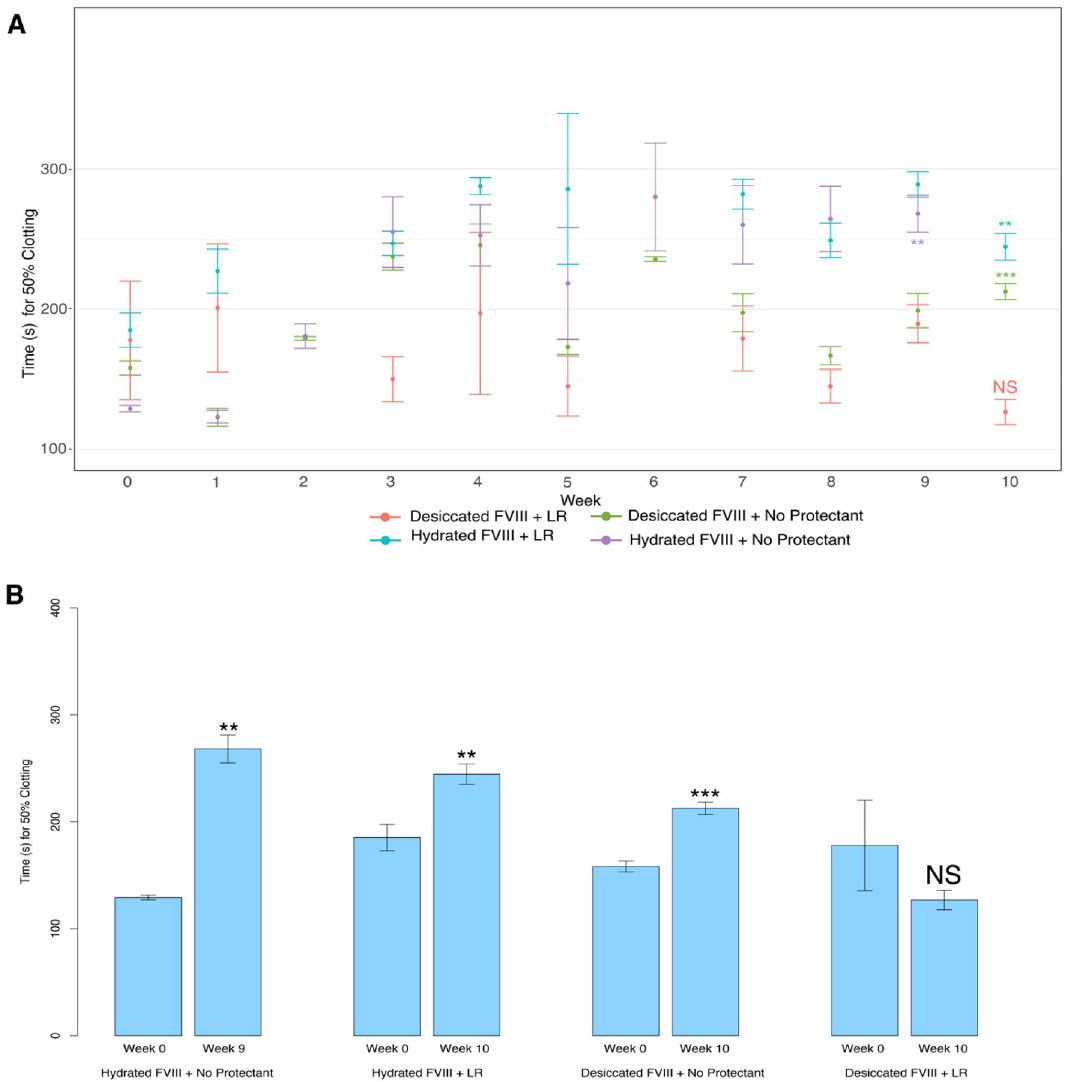
Figure 8. CAHS D Linker Region time course stabilization. 50% clotting time of FVIII in a hydrated or dry state with or without addition of 10 mg/mL of CAHS D Linker Region. Samples were prepared and left dry/ hydrated for 1 to 10 weeks before testing in our clotting assay. ( A ) Shows data from each weekly time point when a 50% clotting time could be established. ( B ) Shows a statistical comparison between the first and last obtainable 50% clotting time. Notations above bar represent statistical comparisons between the first and the last time point taken using a 2-tailed T-test. Error bars represent bi-directional standard deviation. P value > 0.05 = NS, P < 0.05 = *, P < 0.01 = **, P < 0.001 =